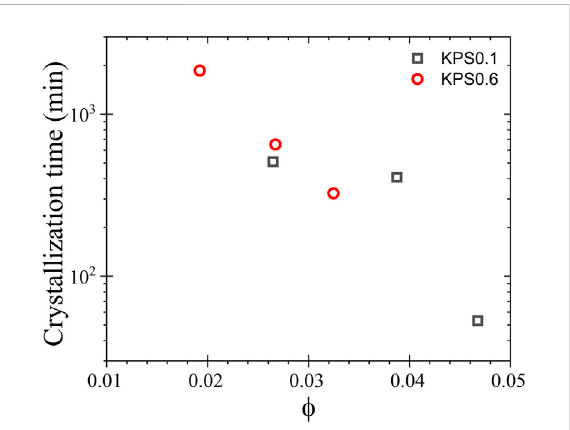
FIGURE 6 Crystallization times as a function of volume fraction occupied by microgels for both systems, KPS 0.1 (black open squares), and KPS 0.6 (red open